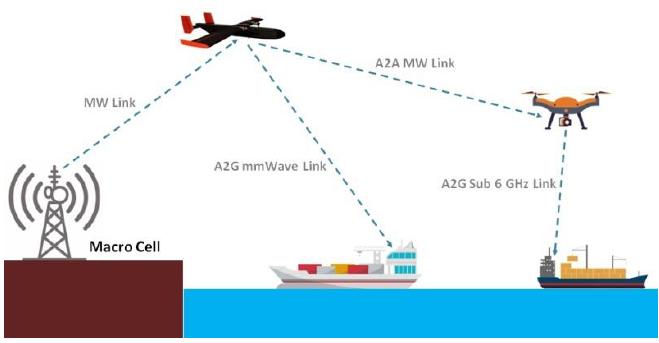
Fig 15. UAV assisted offshore communication